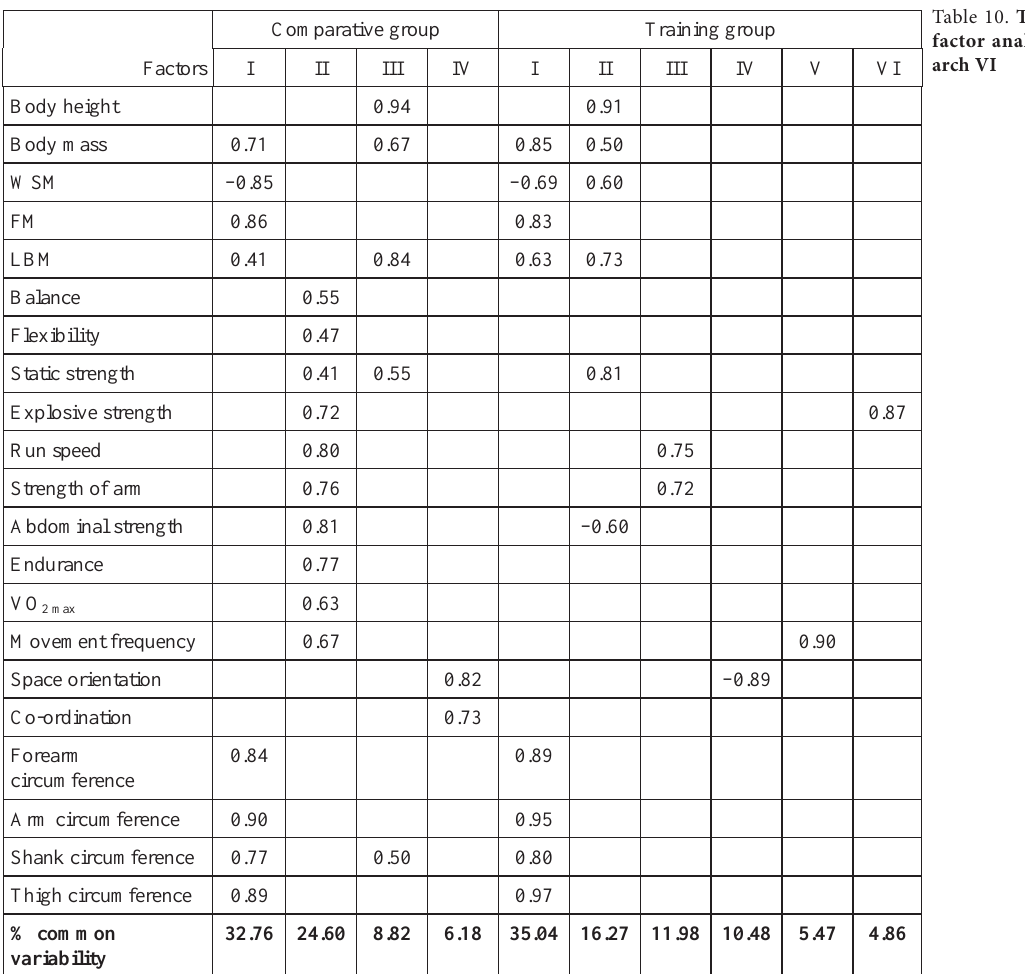
Table 10. Th e results of the factor analysis in the rese- arch